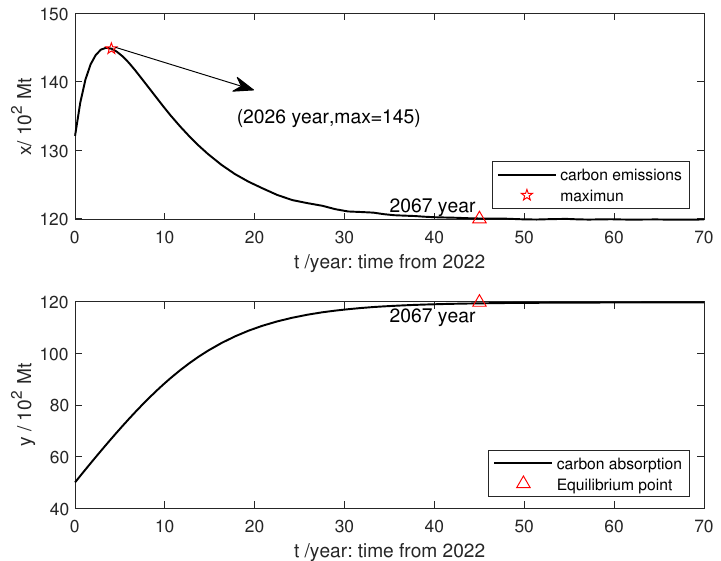
Figure 3. Equilibrium E 3 of system (3) is locally asymptotically stable when τ =